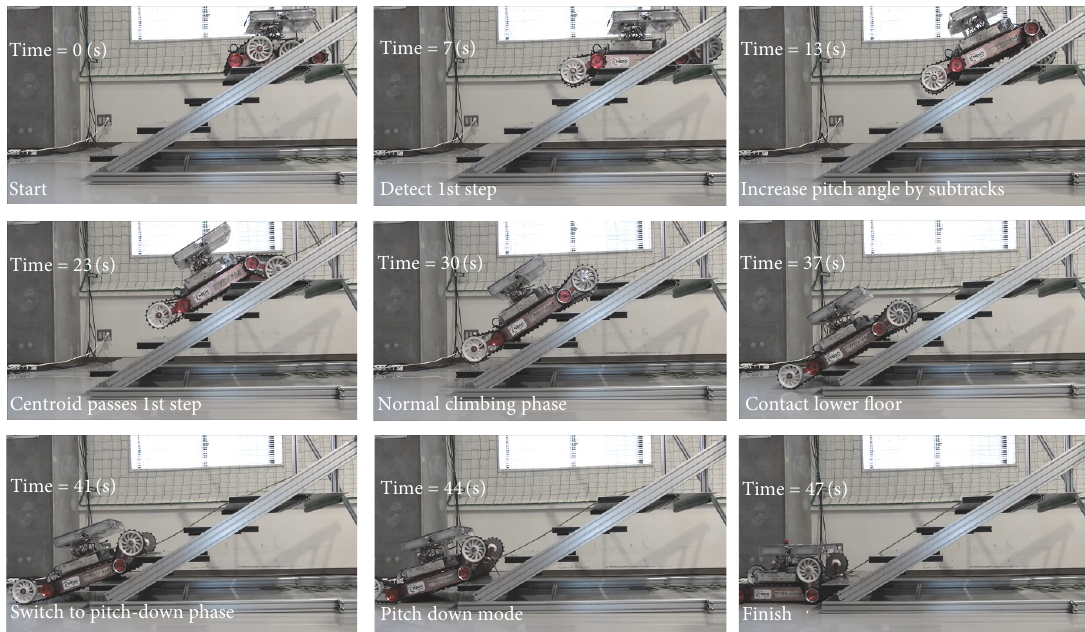
Figure 22: Climbing-down behavior for case 𝜃 𝑠 = 30 ∘ , 𝑝 = 300